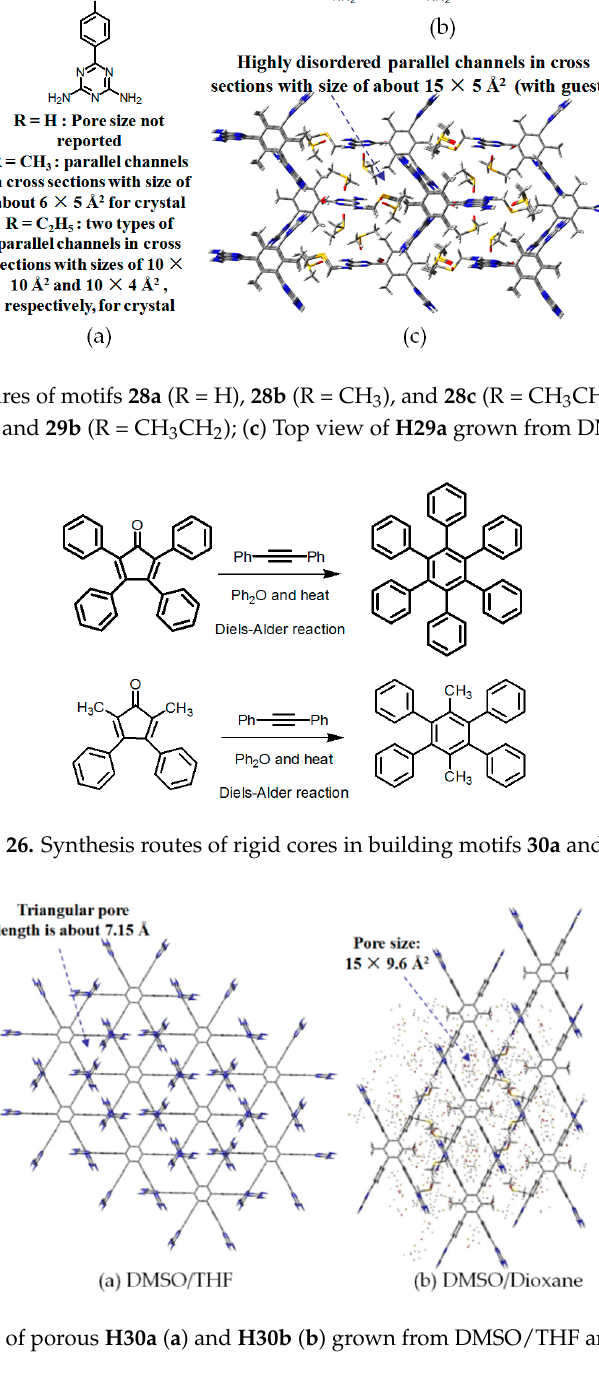
Figure 28. Top views of porous H30a ( a ) and H30b ( b ) grown from DMSO/THF and